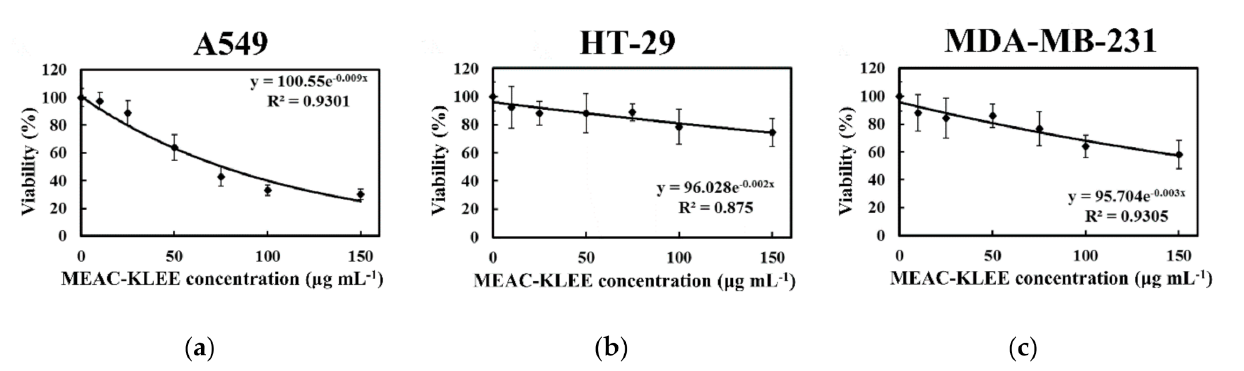
Figure 3. Effects of MEAC-KLEE on cancer cells. After treated with MEAC-KLEE, the viabilities of ( a ) A549, ( b ) HT-29, and ( c ) MDA-MB-231 cells were analyzed according to the formazan-based cell proliferation reagent WST-1 assay. Each value is expressed as the mean ± SD ( n = 3).